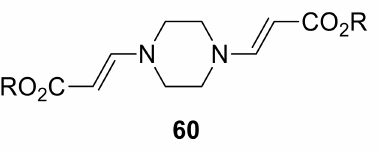
Figure 4. Tertiary enamine intermediate for the synthesis of 1,4-DTs 59